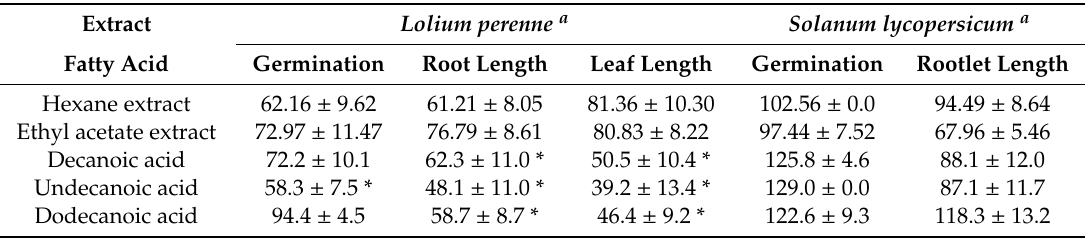
Table 5. Phytotoxic effects of fatty acids (50 µg/cm 2 ) and extracts (100 µg/cm 2 ) on Lolium perenne and Solanum lycopersicum .